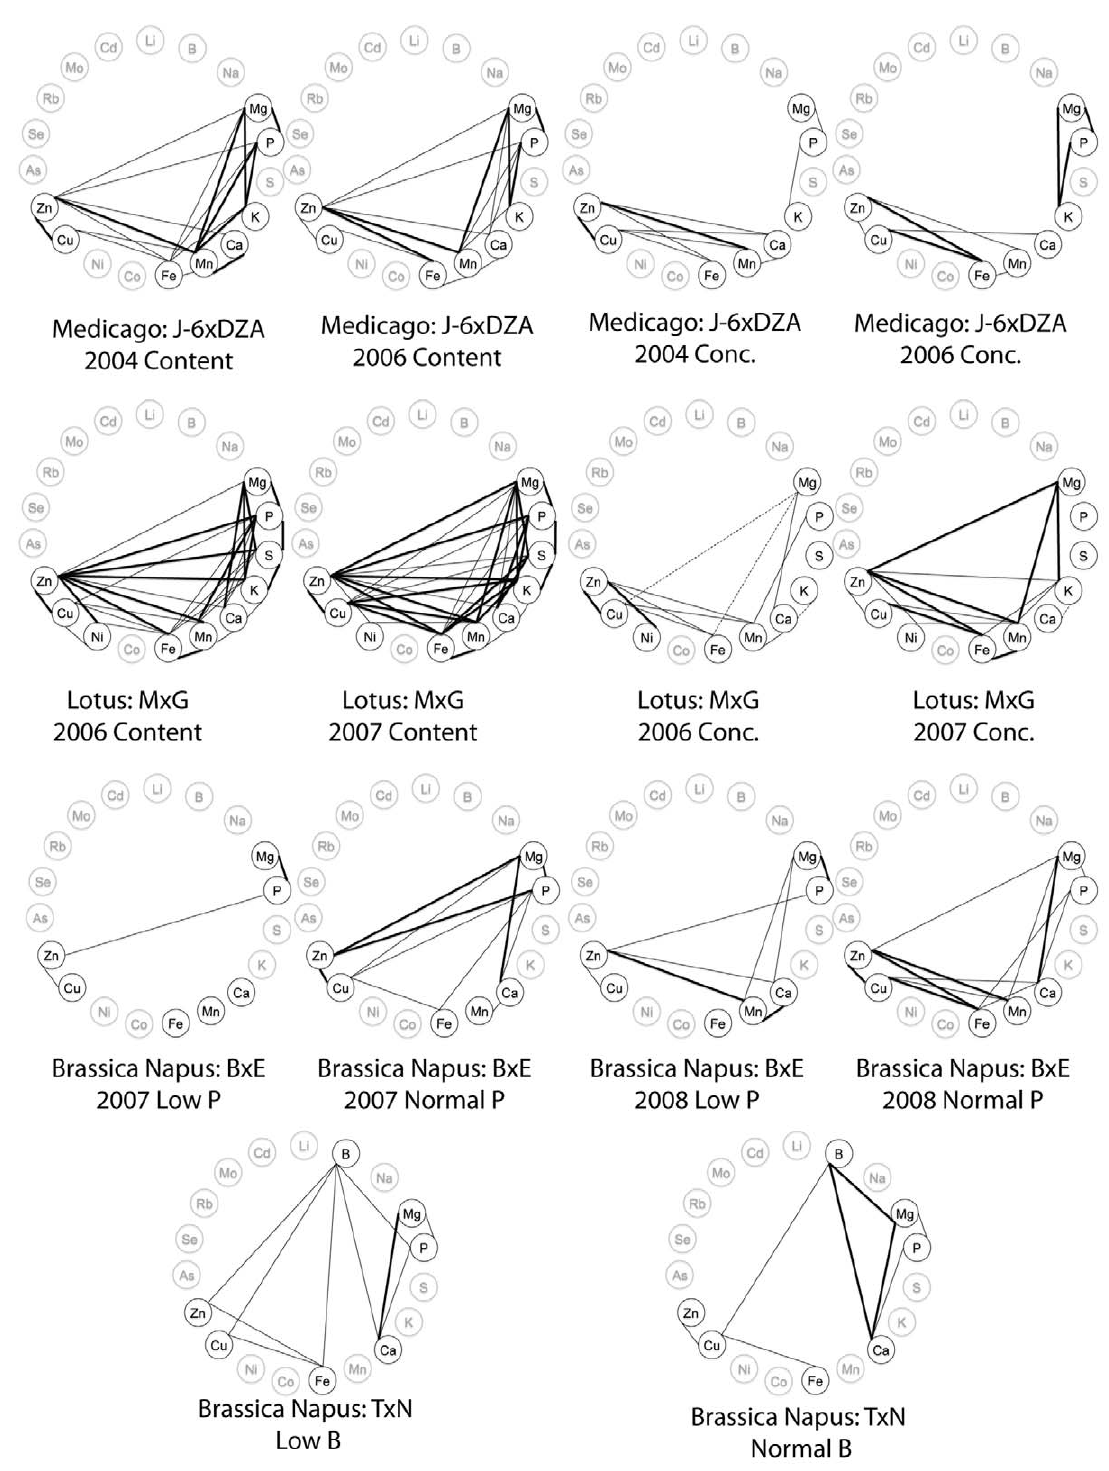
Figure 5. Correlations wheels showing significant correlations between elements within an experiment. A–D from Sankaran et al. [30] Tables 1 & 2 for the Medicago Truncatula Jemalong-6 6 DZA315.16 population. E–H from Klein et al. [28] Table 2. For the Lotus Japonicus Miyakojima MG-20 6 Gifu B-129 population. I–L from Ding et al. [25] Table 2 for the Brassica Napus B104-2 6 Eyou Changjia population. M–n from Liu et al. [29] table 2 for the Brassica Napus Tapidor 6 Ningyou 7 population. Only significant correlations (p , 0.001 and R 2 . 0.32) are displayed on each wheel. Positive correlations are denoted by solid lines, negative correlations are denoted by dashed lines. Thick lines indicate R 2 . 0.5, thin lines indicate 0.32 , R 2 , 0.5. Ions not measured in a given experiment are colored in grey.